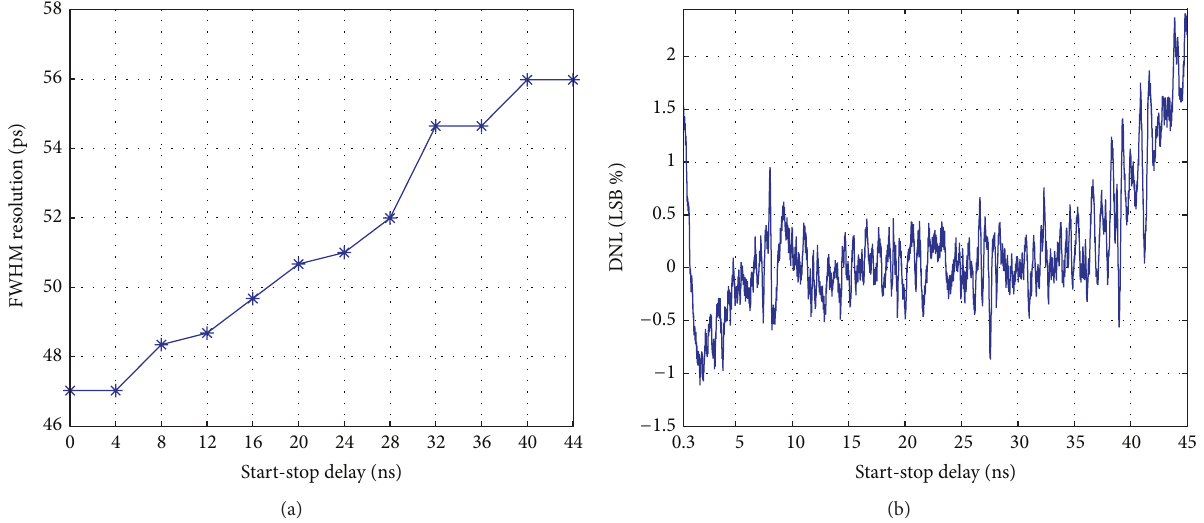
Figure 14: Main performance figures for the 45 ns FSR. (a) FWHM timing resolution. (b) Differential nonlinearity.